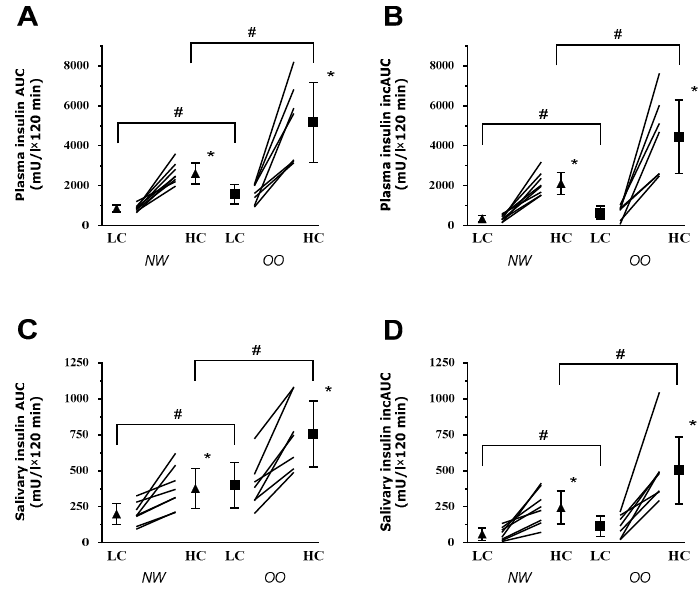
Figure 2. Plasma and saliva insulin area under the curve (AUC) in normal weight (NW) and overweight/obese (OO) following low-carbohydrate (LC) and high-carbohydrate (HC) breakfast meals. ( A ) Plasma AUC in NW and OO participants; ( B ) Plasma incremental AUC (iAUC) in NW and OO participants; ( C ) Saliva AUC in NW and OO participants; and ( D ) Saliva iAUC in NW and OO participants. * p ≤ 0.005 vs. LC meal within group. # p < 0.05 vs. NW group within meal.